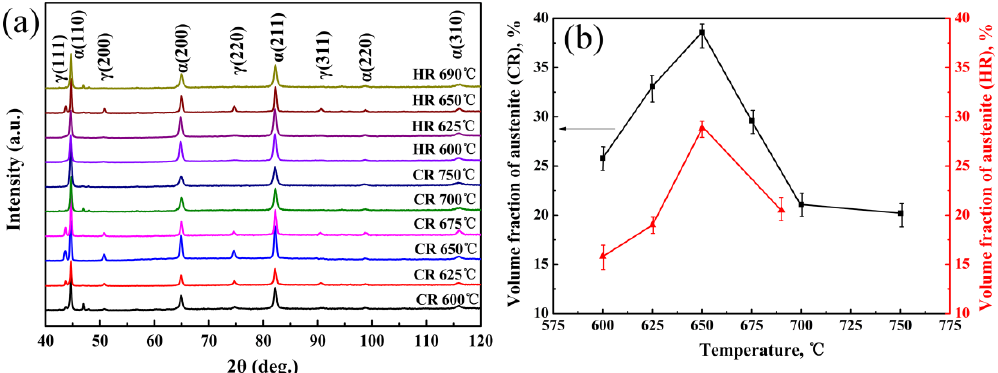
Figure 4. ( a ) X-ray diffraction (XRD) pattern of samples after Q&T treatments and ( b ) the measured austenite fraction with increasing annealing temperature